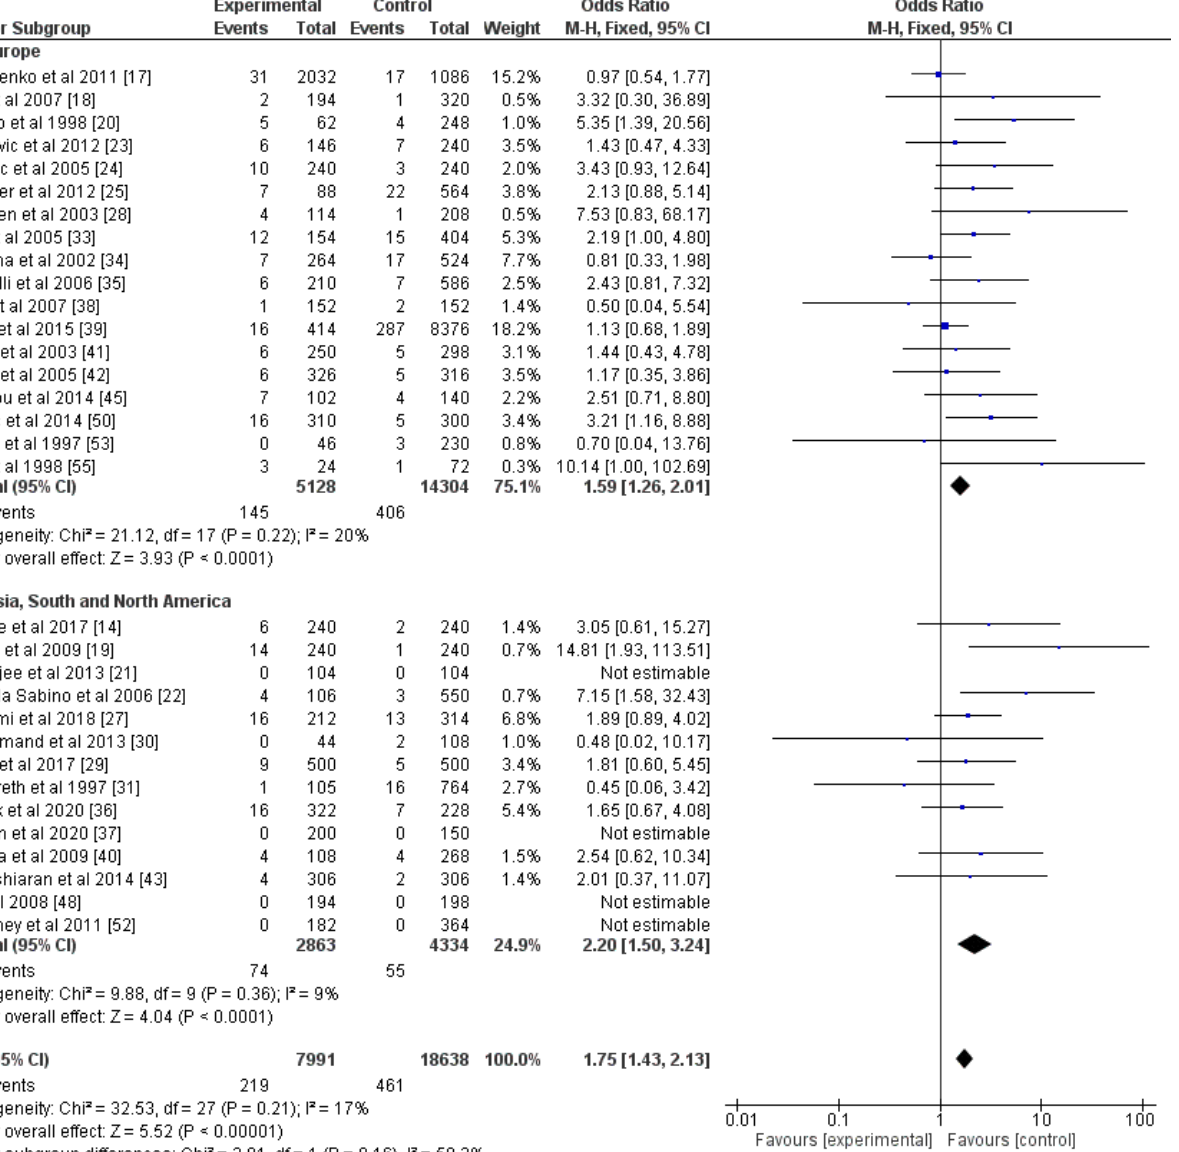
Figure 2. Forest plot for FVL with studies reporting prevalence of hetero- and homozygotes, and sub- group analysis according to geographical localization of studies. All included articles are presented with the corresponding numbers of mutated alleles in the experimental group and the control group, as well as the total number of alleles. Blue squares indicate odds ratios. Black rhombi indicate overall effect. Vertical line indicates null effect, and horizontal lines indicate values of odds ratios.